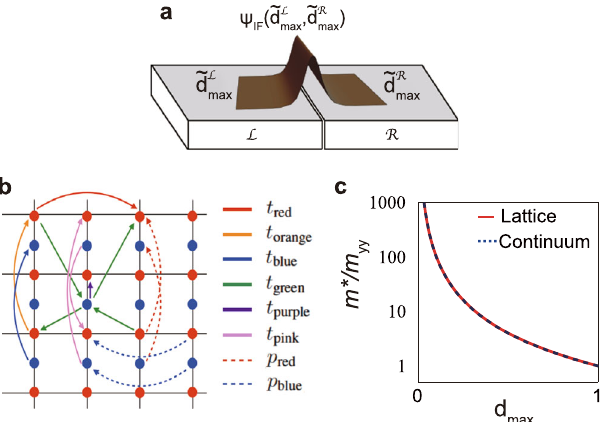
Fig. 2 Interface mode induced by the sign difference of ~ d max . a A junction between two singular fl at-band systems with different values of ~ d max , which is the extended maximum quantum distance. Here, the onsite potential is the same for both sides. b The lattice and hopping structure of the square lattice model hosting a fl at band. Here, t ’ s and p ’ s are the hopping parameters. In this model, d max can be varied from 0 to 1 while maintaining the band fl atness by changing the hopping parameters [see Supplementary Note 4]. c The d max dependence of the effective mass of the interface mode where the step-like sign change of d max is applied, satisfying ~ d max ð x < 0 Þ ¼ (cid:2) d max and ~ d max ð x > 0 Þ ¼ d max . The generic continuum analysis is represented by the dashed line, which is compared with the results obtained from square lattice model illustrated in b . Here, ð m (cid:2) 1 xx ; m (cid:2) 1 xy ; m (cid:2) 1 yy Þ ¼ ð 2 ; 0 ; 2 Þ is used for the mass tensor.